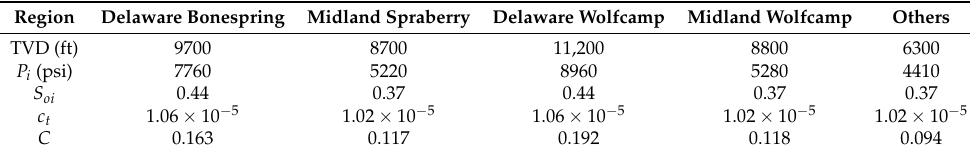
Table A1. Average reservoir properties used for physical